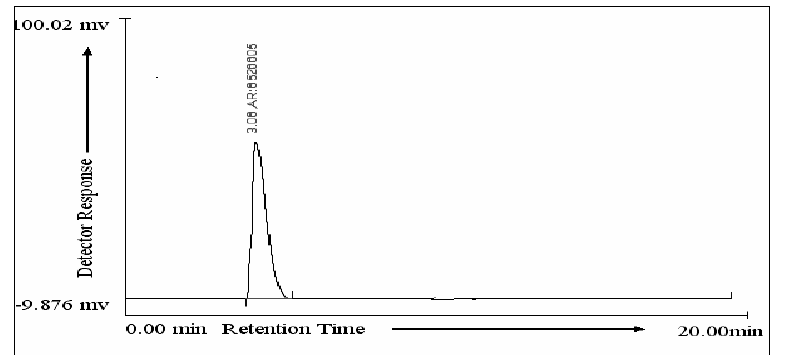
Figure 2 . HPLC spectrum of montelukast (100 ppm) in optimized conditions (RT 3.08 min) Preparation of calibration curve